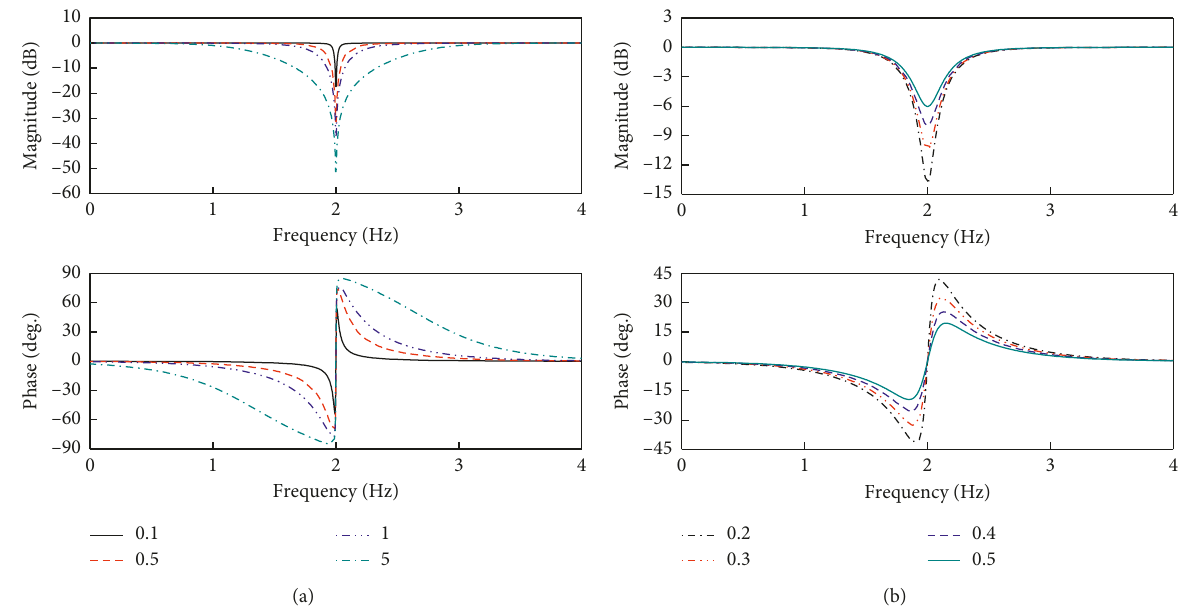
Figure 5: Bode diagram of the adaptive notch filter with different values. (a) a with constant and ξ with different values. (b) ξ with constant and a with different values.